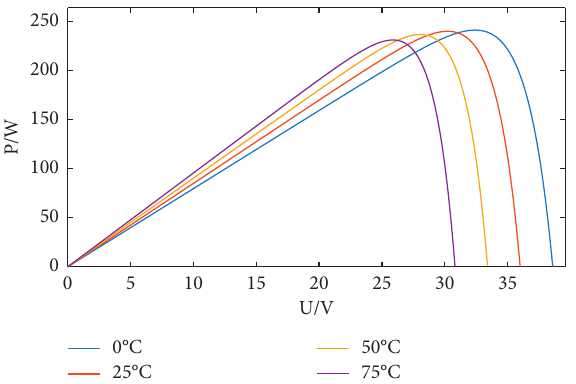
Figure 3: P-U output curve of the photovoltaic cell with the change of light intensity.